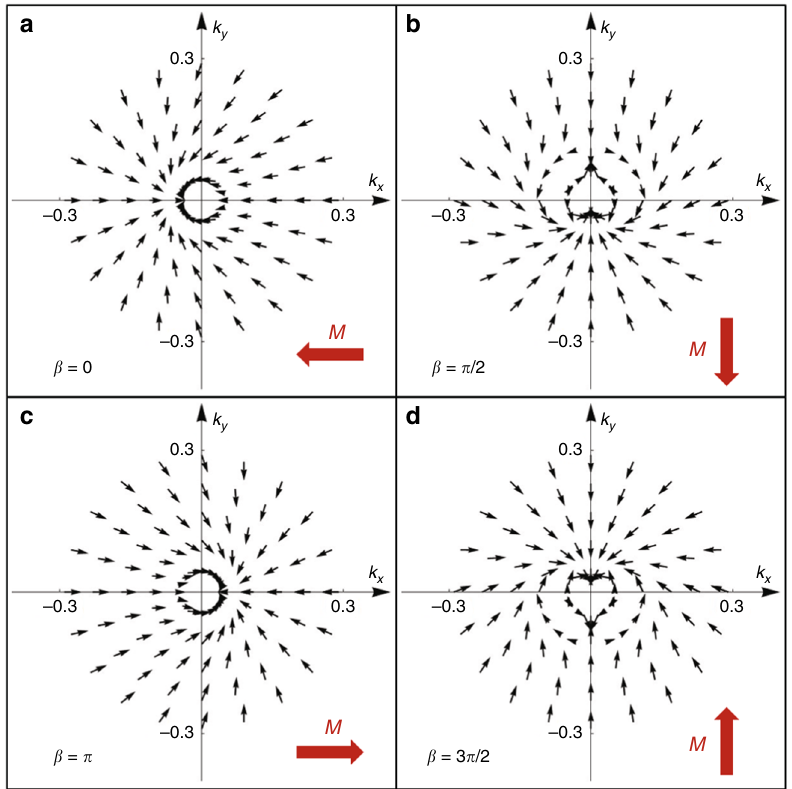
Fig. 3 The in-plane spin texture of the p + ip excitonic insulator. a – d The results for different global phase of the exciton order parameter, β = 0, β = π /2, β = π , β = 3 π /2, respectively. The total net magnetization M is shown by the arrow for each